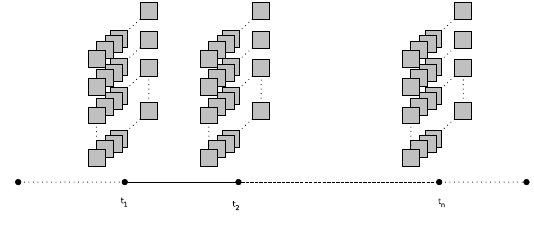
Figure 9. Sparse representation of the raster